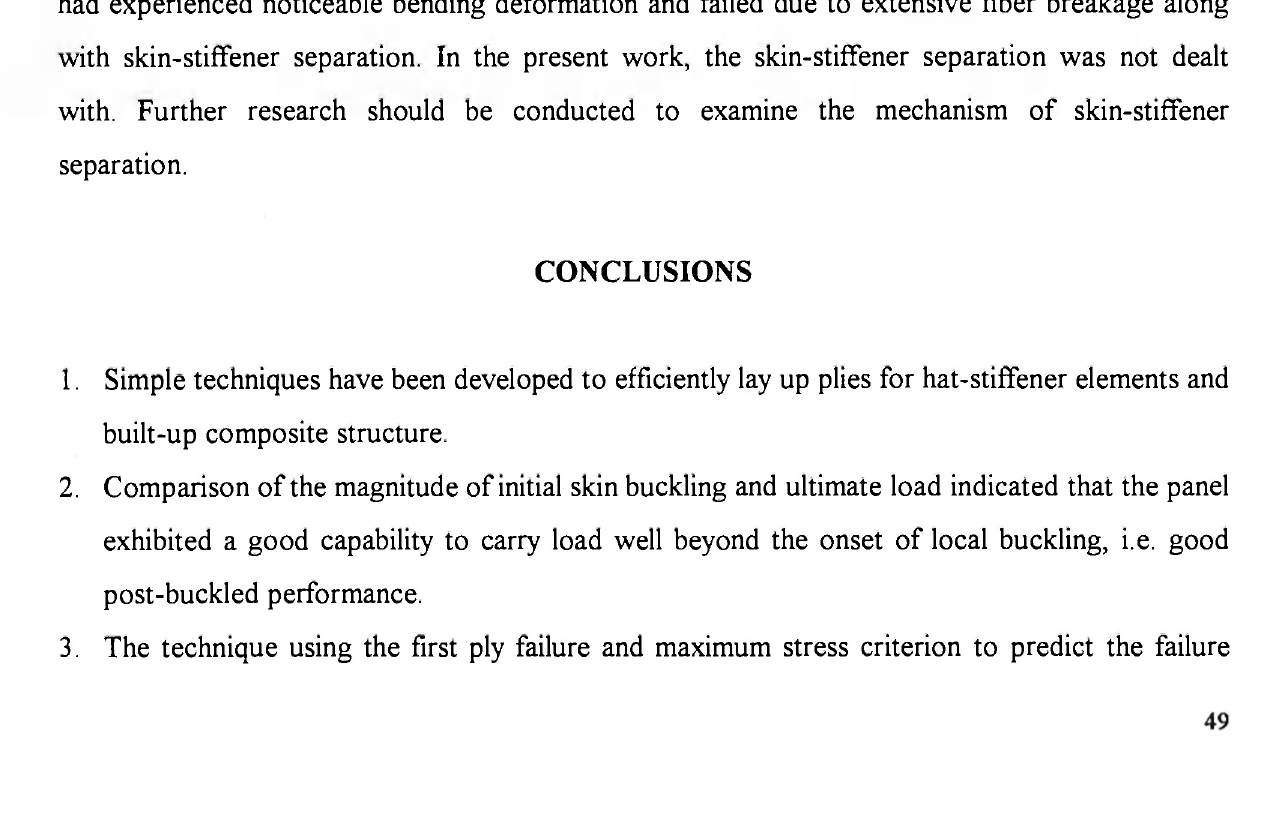
Figure 8. Failed stiffened